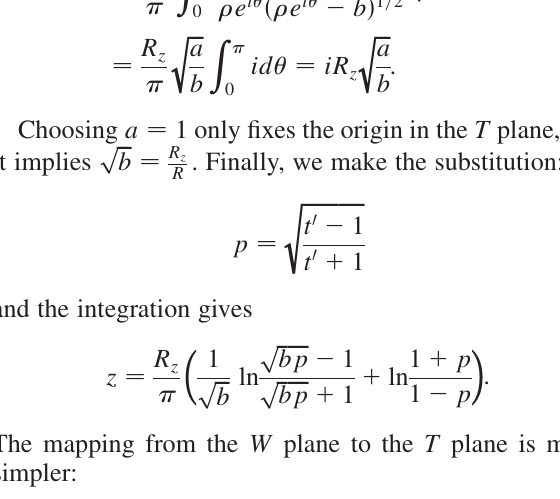
FIG. 5. This figure represents the image of the mapping (cid:3) ð w Þ applied to the rectangle defined as w ¼ u þ iv with (cid:1) 20 < u < 8 and (cid:1) (cid:2) < v < 0 . The dots indicate the position of the z